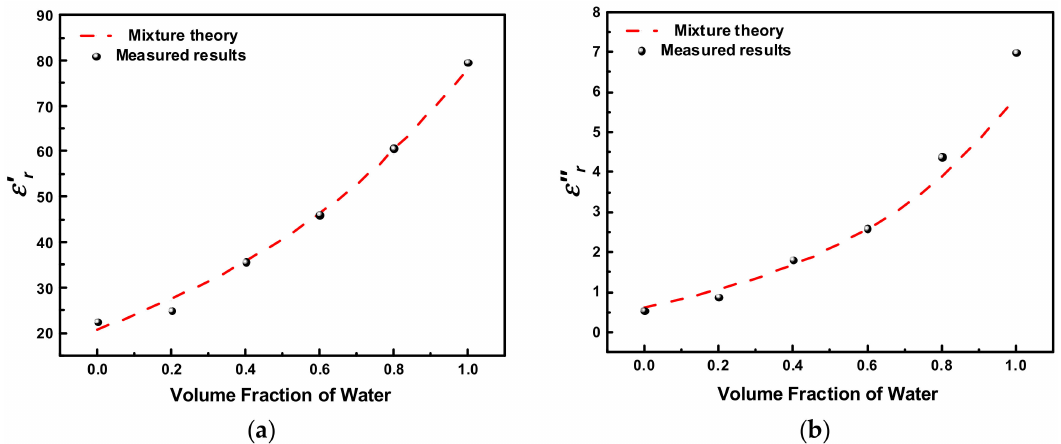
Figure 15. Theoretical and measured ( a ) ε (cid:48) r and ( b ) ε ” r versus volume fraction of water.